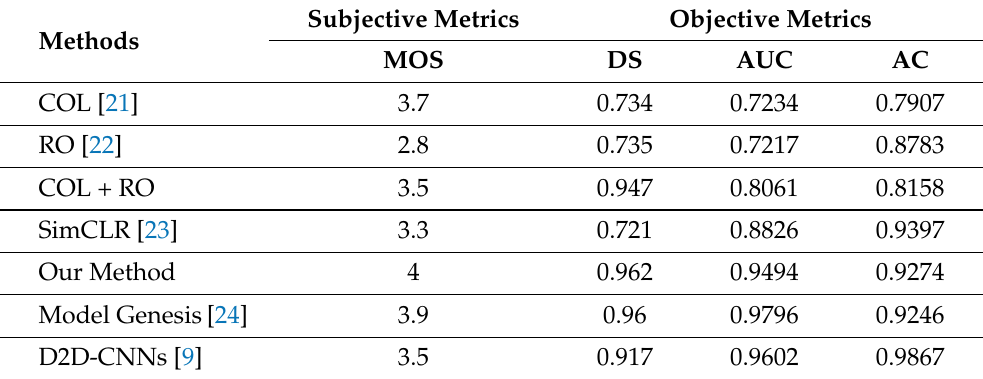
Table 1. Retinal vessel segmentation results (DRIVE Dataset).